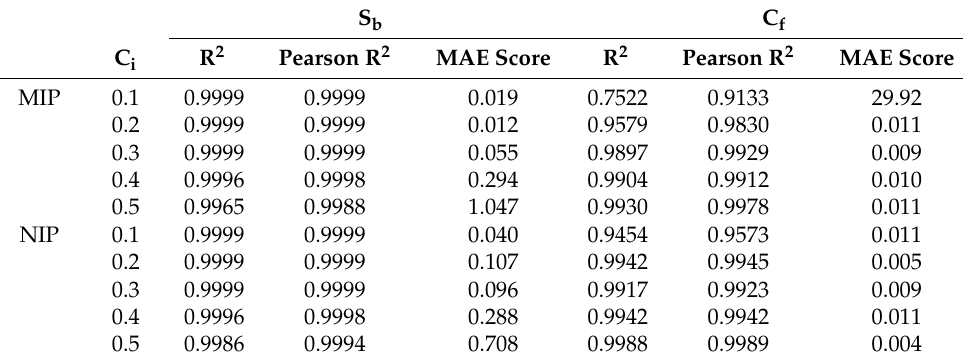
Table 5. Analysis of the error and correlation of the trained datasets at a given C i value for the graph convolution model.